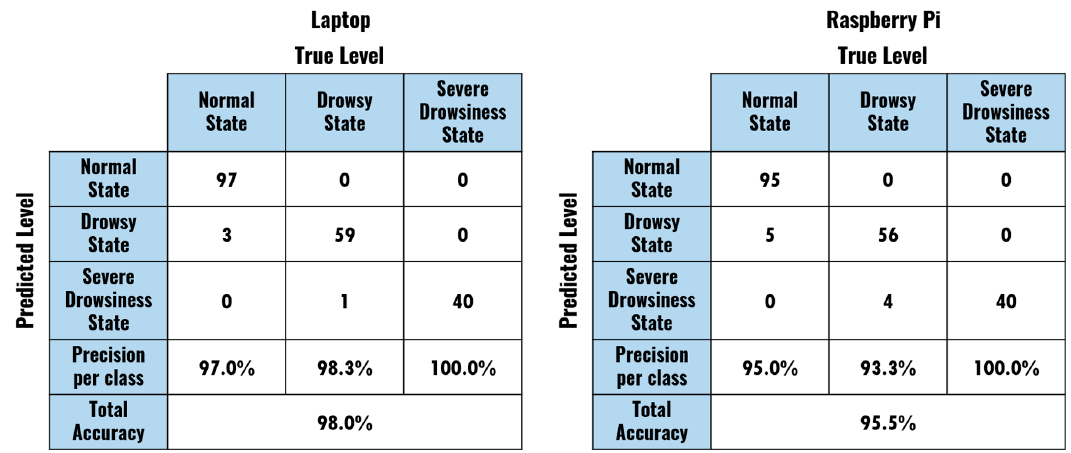
Figure 10. Confusion matrices describing the performance of the model.